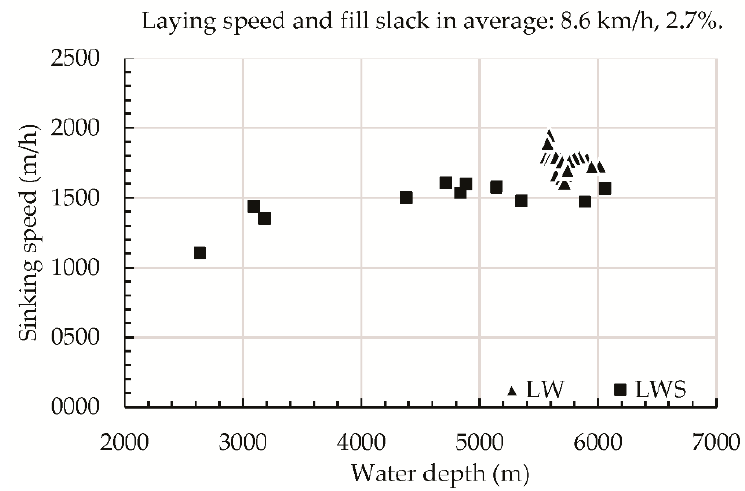
Figure 4. Sinking speed of the repeater, including cable couplings with LW and LWS.